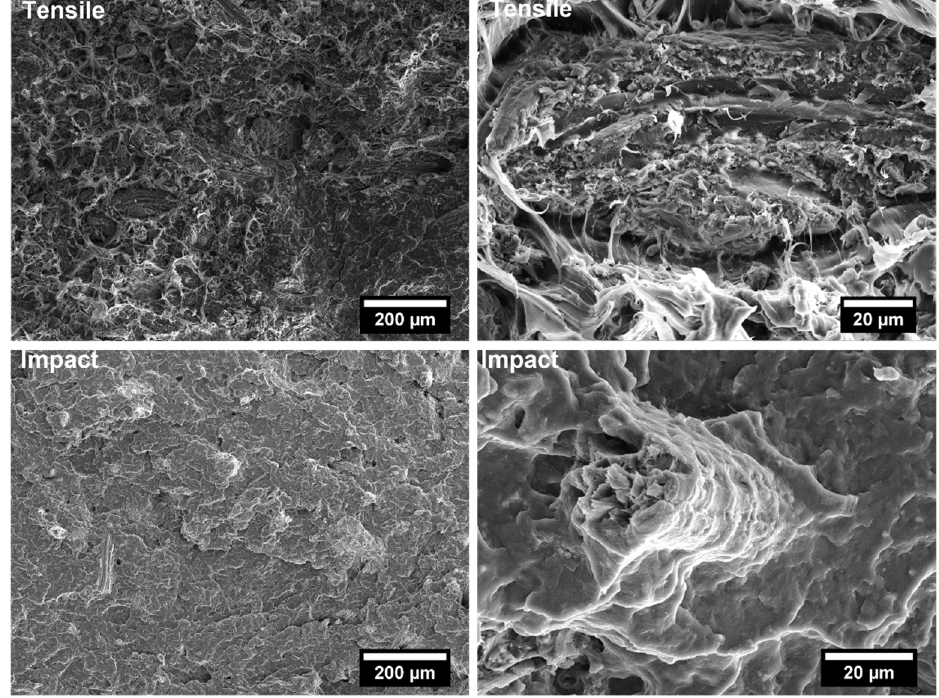
Figure 14. SEM micrographs of PP-based biocomposites with 30 wt.% of palm leaf fillers with coupling agent after tensile and Charpy impact tests.